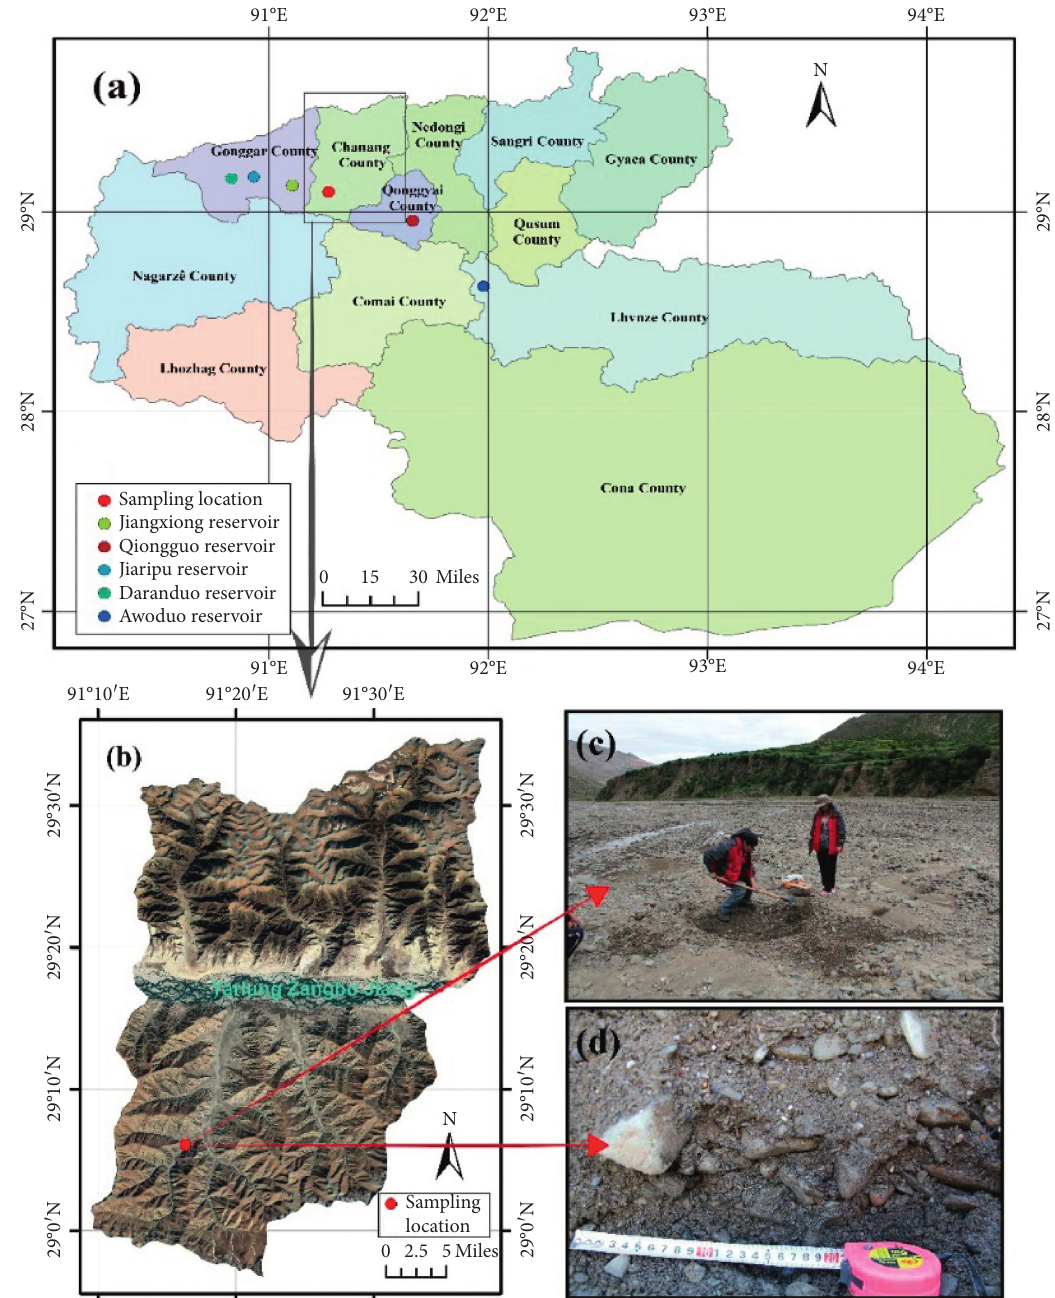
Figure 1: The study site, located on Shannan of Tibet, China. (a) Five typical water reservoirs with leakage in strong infiltrating coarse soil of dam foundation. (b) Location of sample selected and Yarlung Zangbo Jiang river system. (c) Location for sampling site. (d) Status of field soil sediments of the